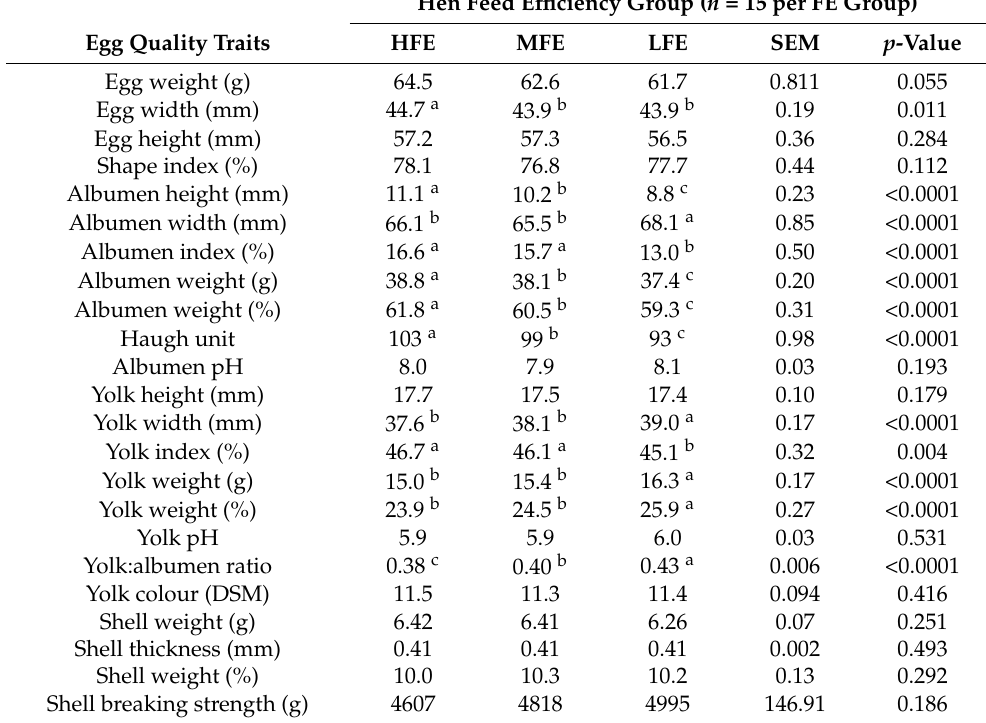
Table 2. Internal and external egg quality characteristics of eggs from individual ISA Brown hens within 35–40 weeks of age, based on differences in feed efficiency.